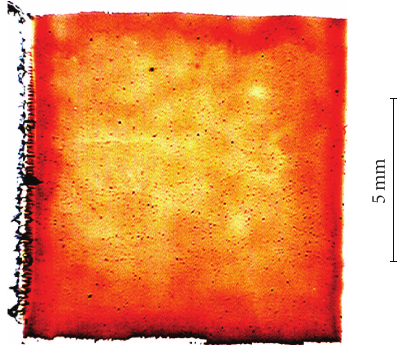
Figure 5: Video image of the cell in Figure 4(a), obtained under light transmission and after contrast